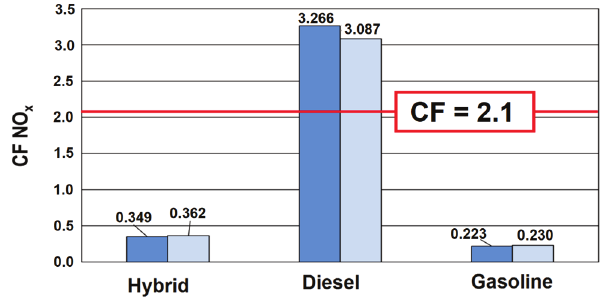
Fig. 17. Values of nitrogen oxide CF emission conformity factors for each of the vehicles in the whole RDE test (EMROAD and all